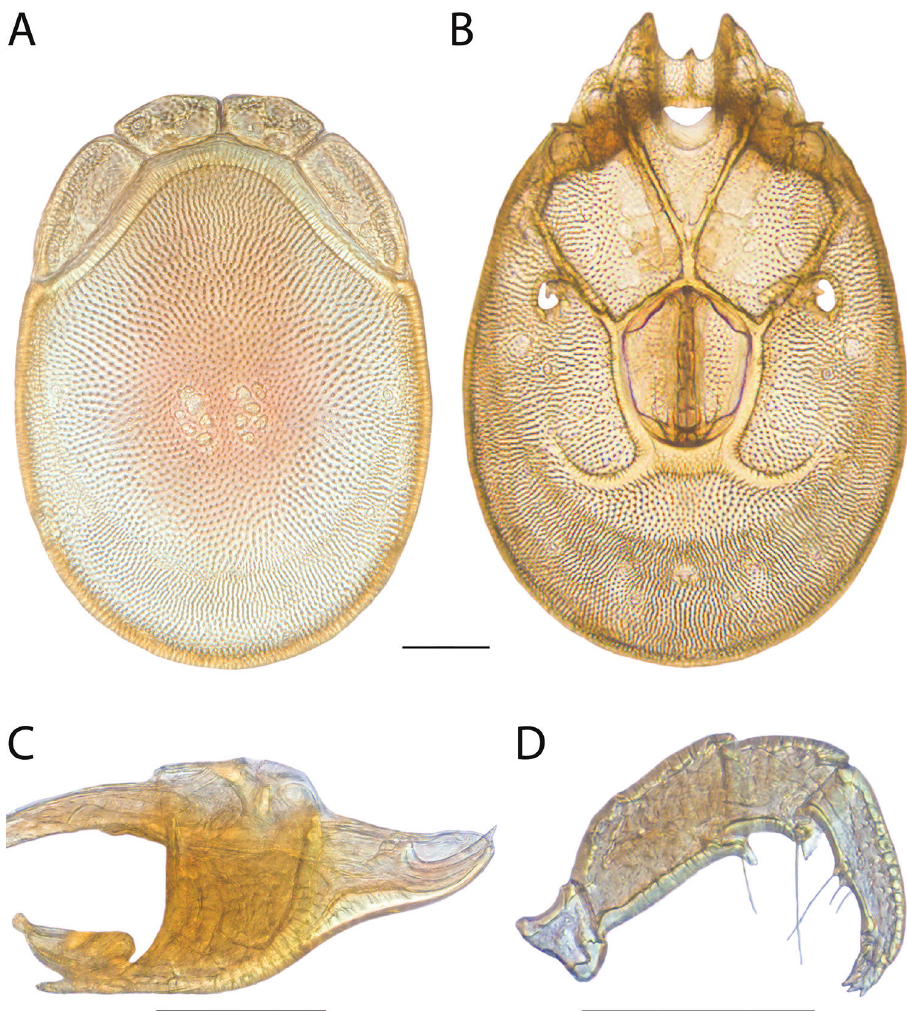
Figure 185. Torrenticola pearsoni sp. n. female: A dorsal plates B venter (legs removed) C subcapitulum D pedipalp (setae not accurately depicted). Scale = 100